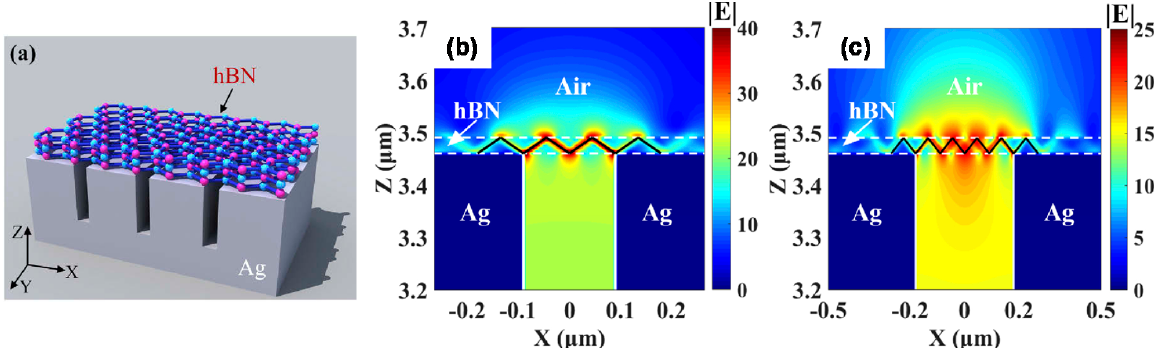
Figure 10. ( a ) Schematic of hBN on one-dimensional (1D) plasmonic grating. Electric field distribution of hBN on 1D plasmonic gratings with groove widths of ( b ) 180 and ( c ) 360 nm. Figures were adapted with permission from [81]. Copyright 2020 Optica.